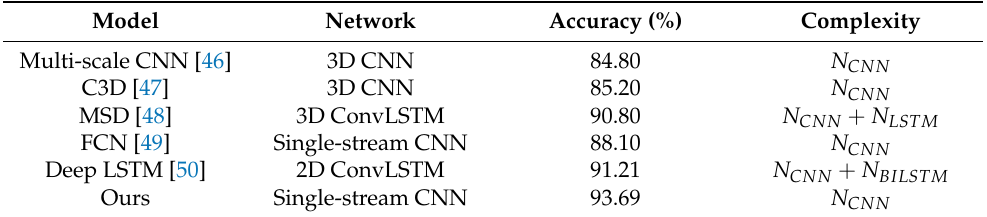
Table 2. Comparison of average accuracy of the proposed method for UCF-101 with other methods.